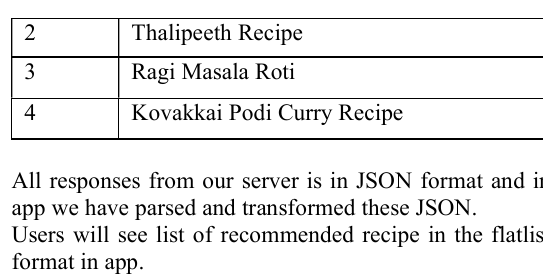
Fig. 3. Flowchart of recommendation